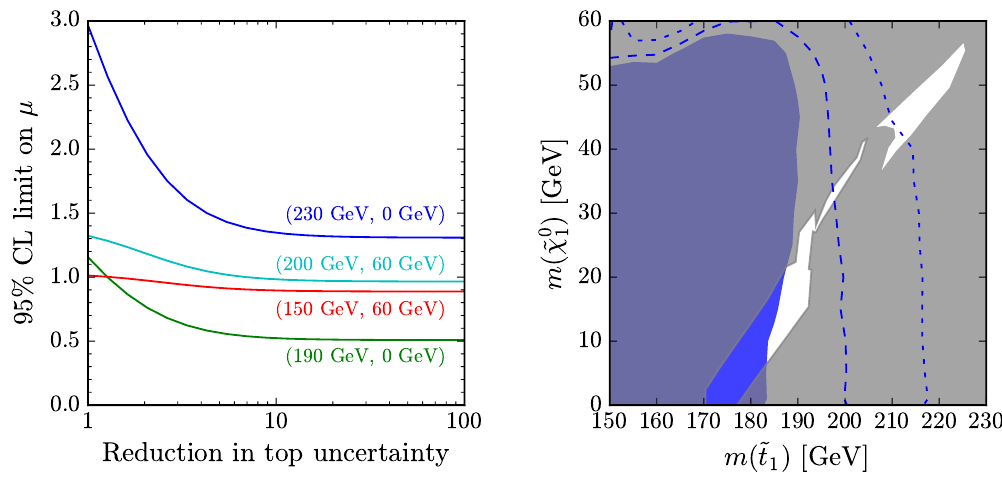
Figure 13 . The left panel shows the 95% CL limit as a function of the t (cid:22) t uncertainty reduction for four points in the ( m (~ t 1 ) ; m (~ (cid:31) 0 )) parameter space. The right panel shows how the limit in the 1 m (~ (cid:31) 0 ) versus m ( ~ t 1 ) plane could be improved if the uncertainty on the t (cid:22) t cross section were reduced 1 by factors of 2 (dashed) and 10